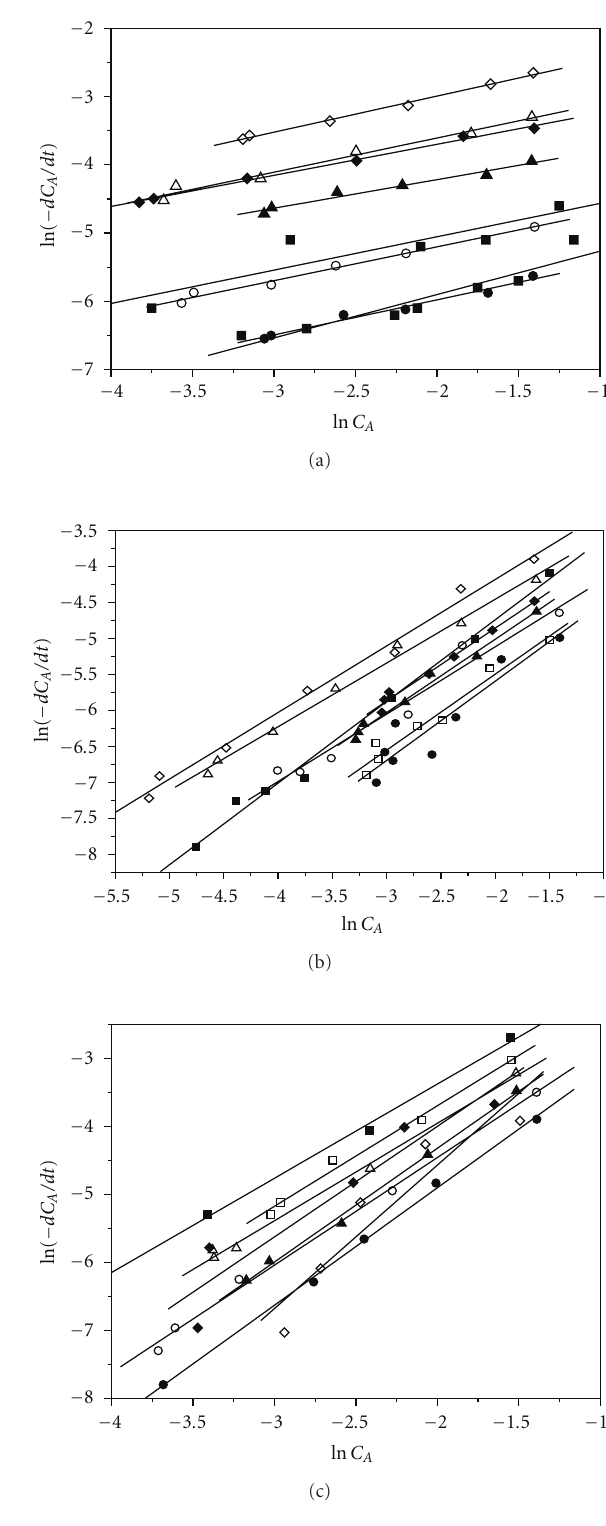
Figure 5: Dependence ln( − dC A /dt ) of ln( C A ) for the allicin trans- formation by conventional method (a), under the influence of ultrasound (b) and microwaves (c). ( (cid:2) Acetonitrile 55 ◦ C; (cid:5) Acetonitrile 45 ◦ C; • Acetone 55 ◦ C; ◦ Acetone 45 ◦ C; (cid:3) Methanol 55 ◦ C; (cid:4) Methanol 45 ◦ C; (cid:4) Chloroform 55 ◦ C; ♦ Chloroform 45 ◦